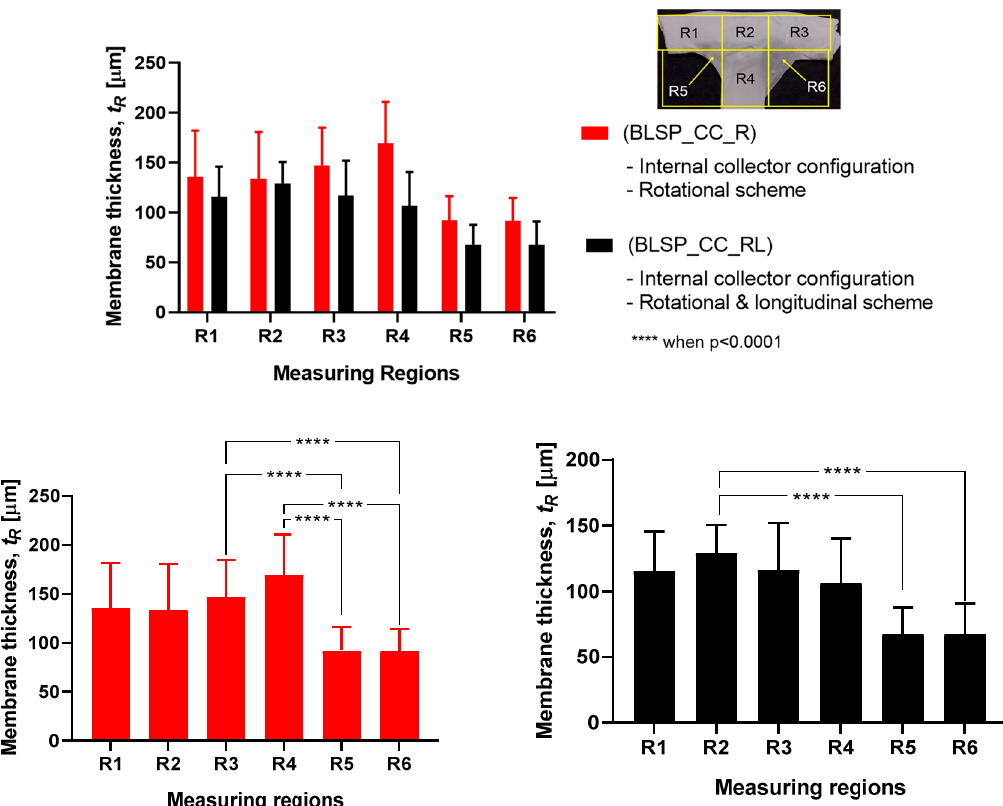
Figure 16. Membrane thickness distribution along the vascular graft membrane surface. (A two-way ANOVA was performed to determine any statistically significant differences between experiments.).